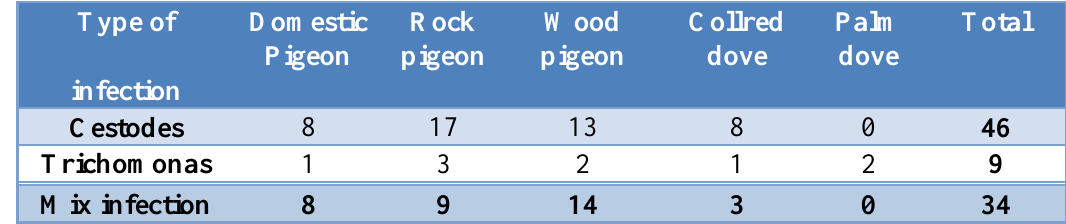
Table, 7: The concurrent infection with cestode and trichomoniasis in columbides. Type of